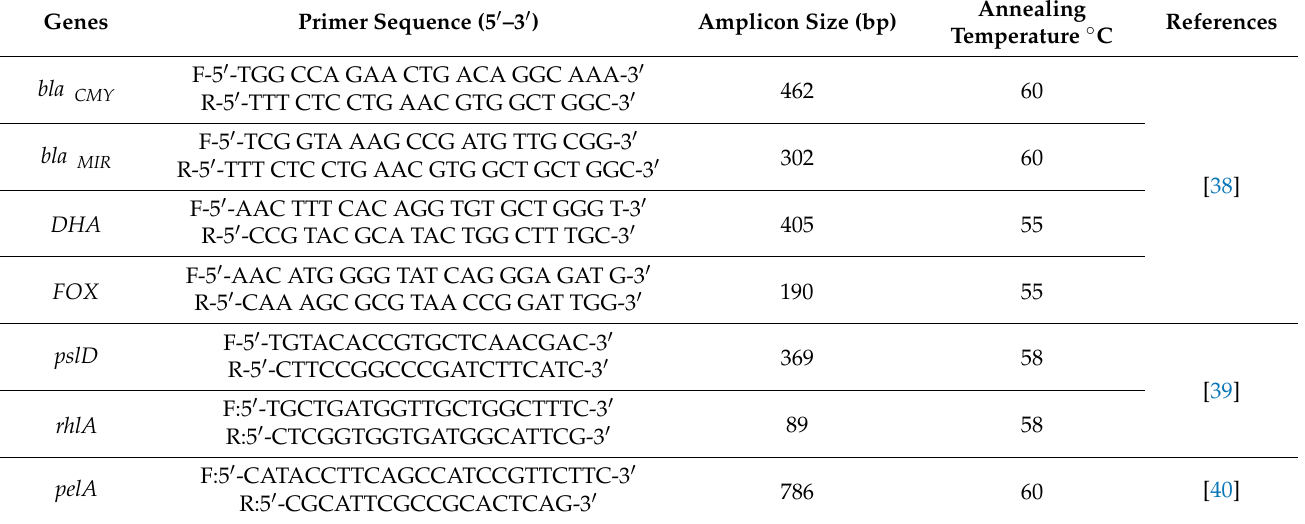
Table 1. Primers used in this